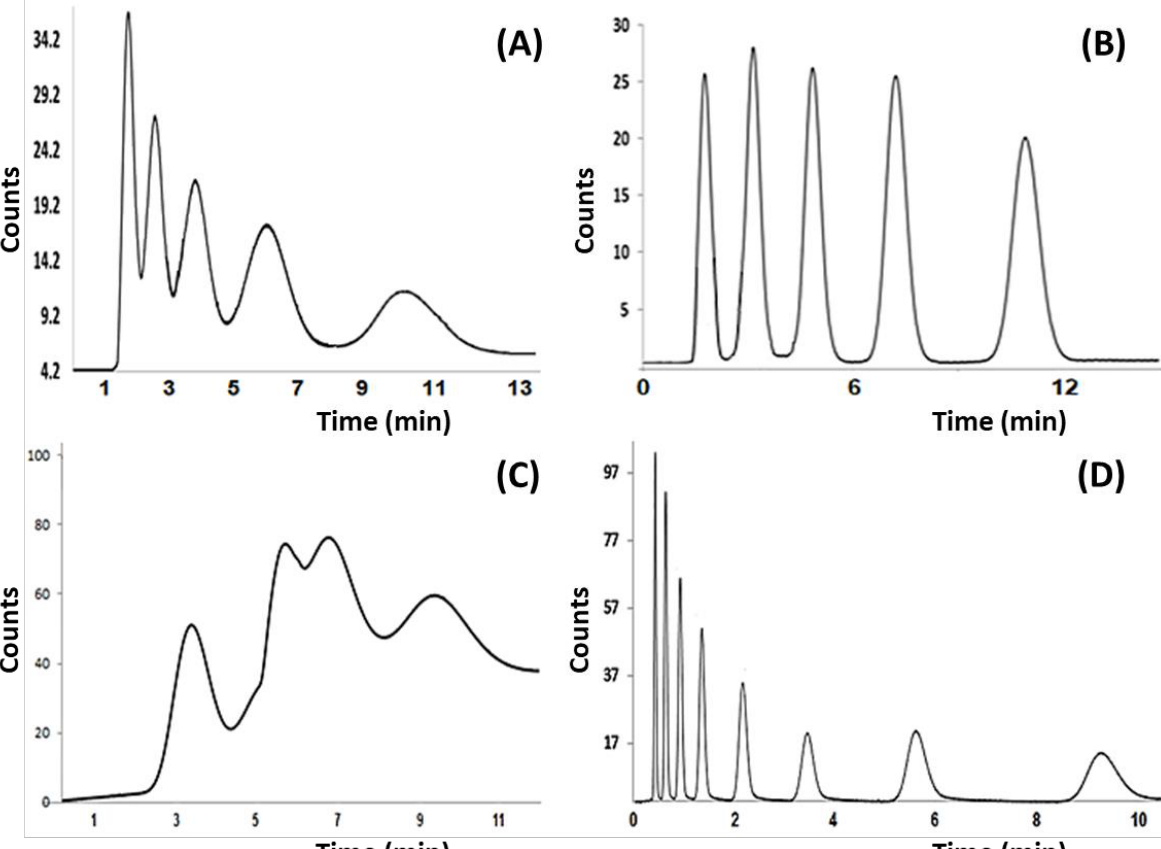
Figure 4. GC separation of alkane series under the optimal conditions using GMA ( A ) and MMT@poly(GMA-co-EDMA) ( B ). Conditions: flow rate: 1.0 mL min − 1 , injector temperature: 200 ◦ C, temperature program: 110–180 ◦ C, 50 ◦ C min − 1 , detector temperature: 200 ◦ C. Compounds in order of elution: pentane, hexane, heptane, octane, and nonane (20%, v / v % for each compound). GC separation of alkylbenzene series under the optimal conditions using GMA ( C ) and MMT@poly(GMA- co-EDMA) ( D ). Conditions: flow rate: 0.4 mL min − 1 , injector temperature: 200 ◦ C, oven temperature: 160 ◦ C isothermal, detector temperature: 200 ◦ C. Compounds in order of elution: benzene,